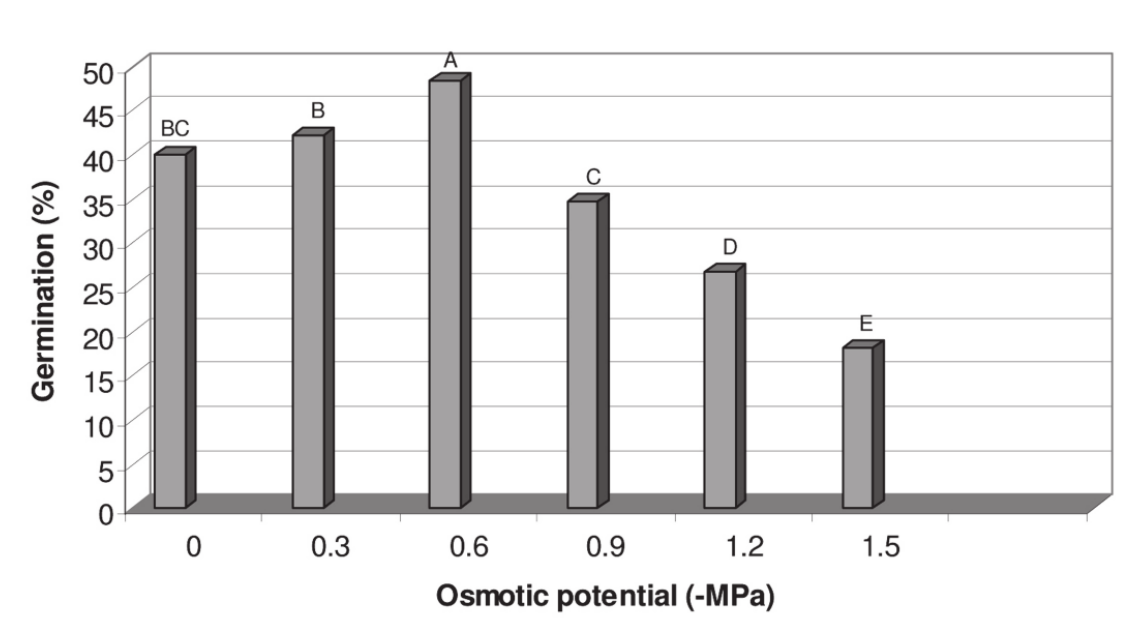
Matric potential Y= -37. 627 X + 63.233 R 2 =0.9486 **